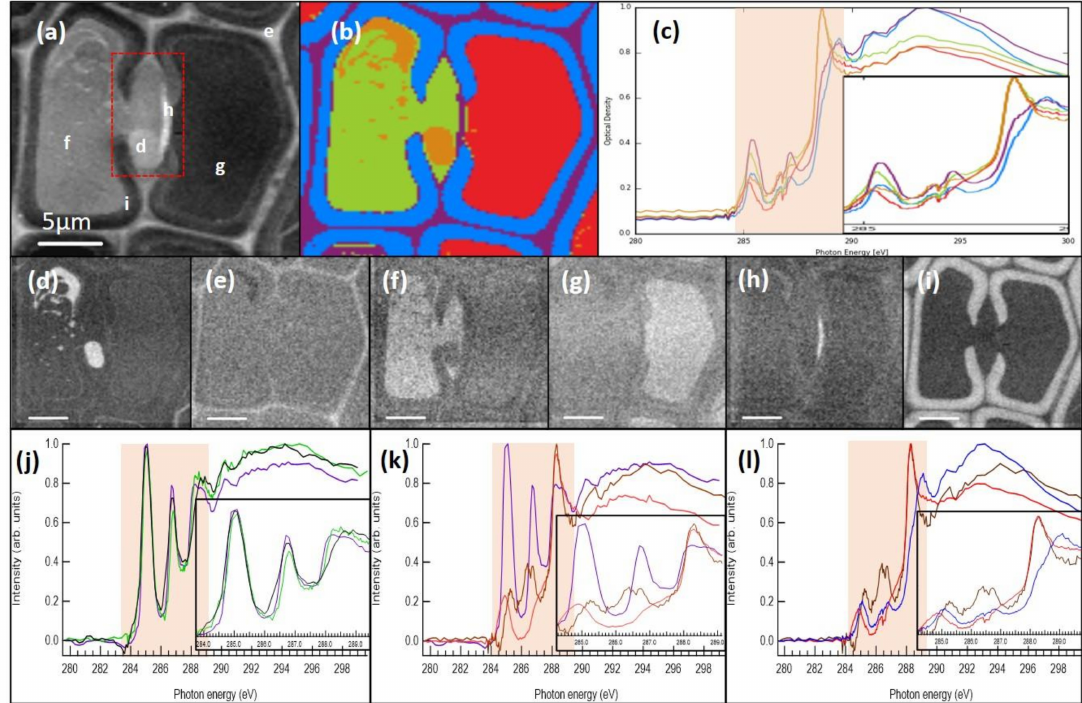
Figure 4. Cell structures of the resin-embedded knotwood tracheids with some deposit material measured at the C 1s absorption edge. ( a ) Average optical density map of STXM measurement with measurement locations for the structural spectra ( d – i ); the bordered pit pair is marked with a red square, ( b ) cluster analysis of the STXM measurement, ( c ) average cluster spectra of the cluster analysis. Localisations of ( d ) the measured deposit in the bordered pit chamber, ( e ) cell corner and compound middle lamella, ( f ) left tracheid, ( g ) right tracheid, ( h ) torus, ( i ) secondary cell wall spectra. ( j ) Spectra of the epoxy-resin-subtracted left tracheid (green), the reference lignan HMR (purple) and the tissue culture lignin (black). ( k ) Spectra of the epoxy-resin-subtracted deposit material (brown), the reference epoxy resin (red) and HMR (purple). ( l ) Spectra of the epoxy-resin-subtracted deposit material (brown), the epoxy resin from the tracheid g (red) and the secondary cell wall (blue). The scale bars in all images are 5 µ